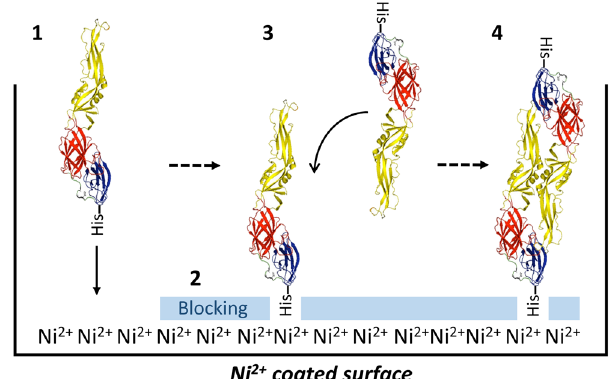
Figure 6. Schematic representation of the postulated model for sRecE-dimer assembly from immobilized monomers. ( 1 ) sRecE is chelated to Ni 2 + -coated plates. The immobilization of sRecE at its C-terminal end presumably locks the protein in a specific conformation. ( 2 ) The plates are subsequently blocked and ( 3 ) reloaded with sRecE at high protein concentrations. ( 4 ) This enables interaction of the immobilized sRecE with the reloaded proteins and generates quaternary epitopes that can be recognized by E-dimer epitope dependent